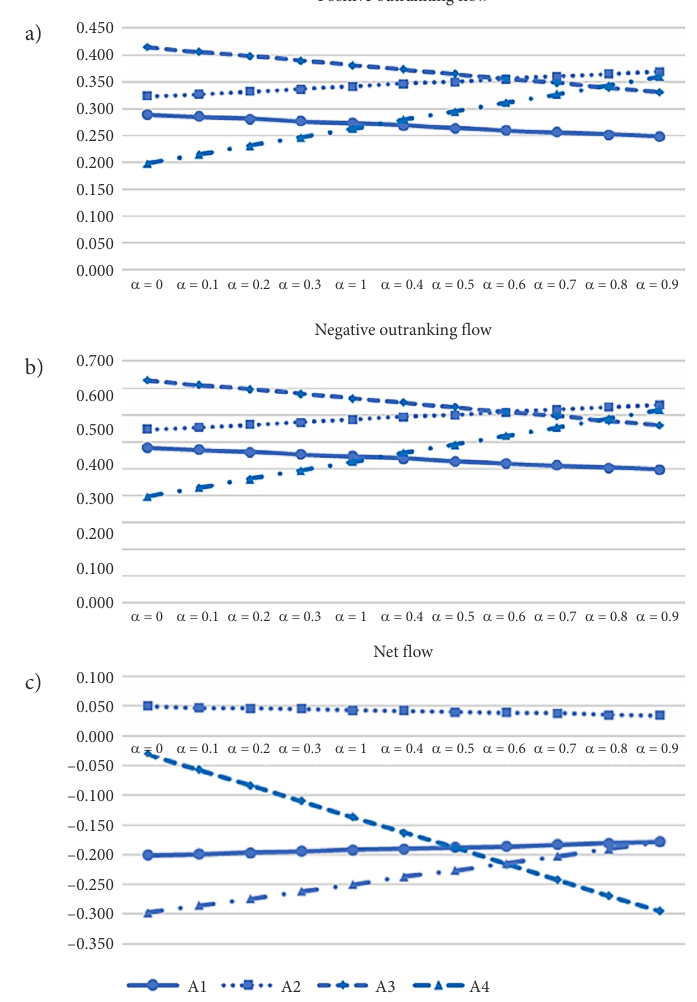
Figure. 3. Sensitivity of positive outranking flow, negative outranking flow and net